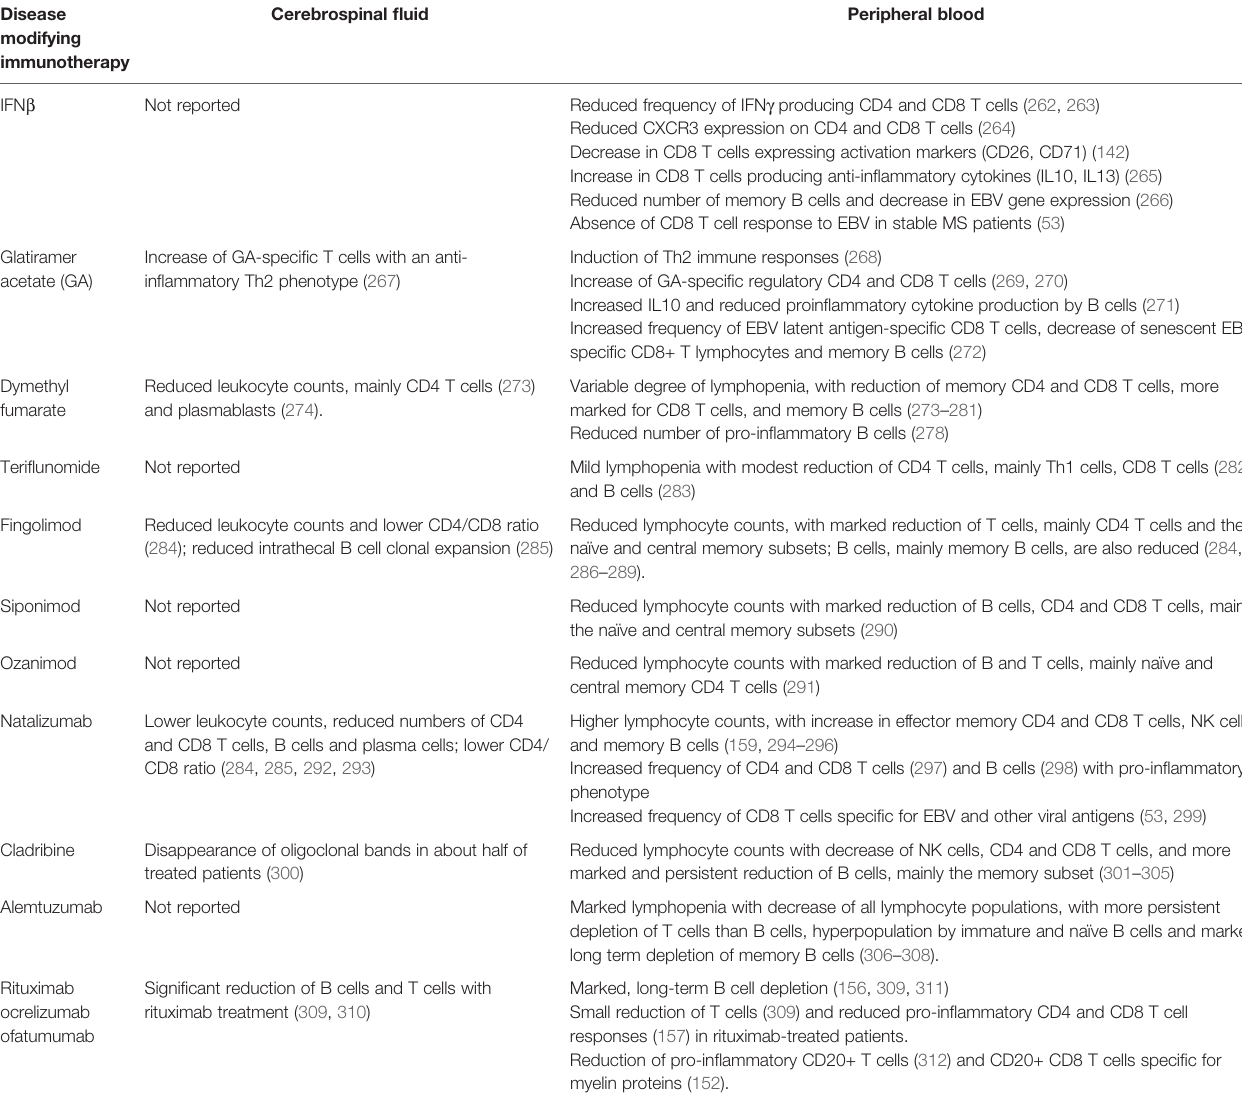
TABLE 2 | Effects of MS therapies on T cells and B cells in the cerebrospinal fl uid and peripheral blood of patients with multiple sclerosis. Disease